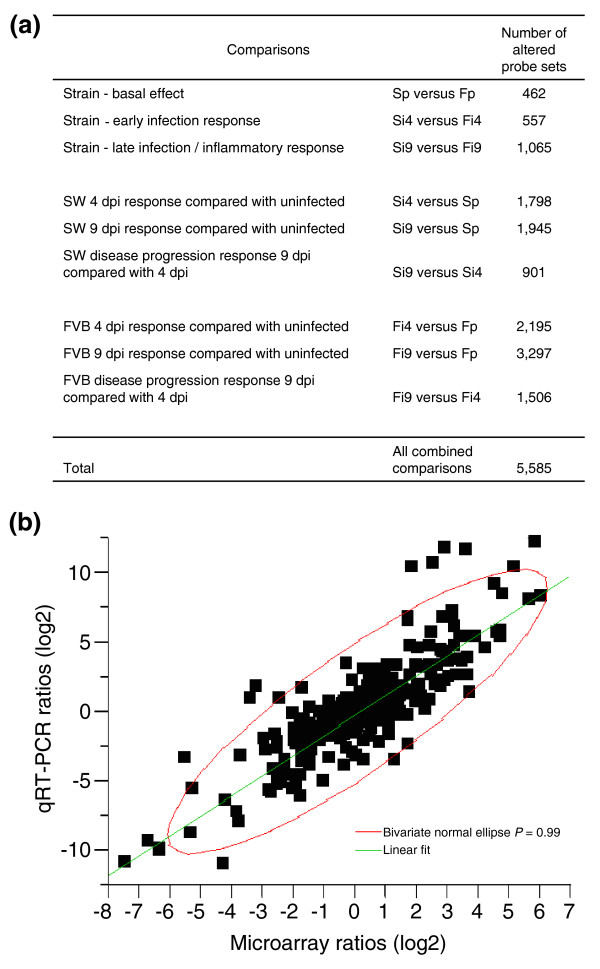
Differential expression of genes between and within the lines of mice prior to, and in response to, C. rodentium infection. (a) Summary of transcripts differentially expressed in individual and combined comparisons. The analysis was performed using an Affymetrix whole mouse genome oligonucleotide chip (430 2.0 Array), which contains >45,000 probe sets comprising expression levels of >39,000 transcripts and variants from >34,000 well-characterized mouse genes. The normalization and processing of the results were performed using DNA-Chip Analyzer (dChip) software implementing model-based expression analysis. One percent of the total probe sets presented on the array were more than two-fold differentially expressed between SW and FVB mice prior to infection. In response to C. rodentium inoculation, 11.4% of the probe sets were either induced or repressed in one or both of the lines of mice. There were more differentially expressed genes in response to infection in susceptible FVB mice than in resistant SW mice, especially as disease progressed. Overall, alterations in 12.4% of the probe sets were detected throughout the experiment. (b) Validation of microarray results by qRT-PCR (TaqMan) of selected genes. Transcript levels were normalized to the endogenous control GAPDH, and expressed as fold change compared with untreated control FVB mice, which were set at 1, using the Comparative Ct method. The resultant log2 ratios were matched with corresponding log2 ratios detected in microarray analysis and subjected to Pearson correlation analysis. Significant correlation was observed between the two assays (Pearson correlation coefficient r = 0.87, R2 = 0.75, p < 0.0001). Pearson correlations for individual genes ranged from 0.67 to 1. Only two out of 35 examined genes did not confirm the array results, yielding a predictability rate of 94%.